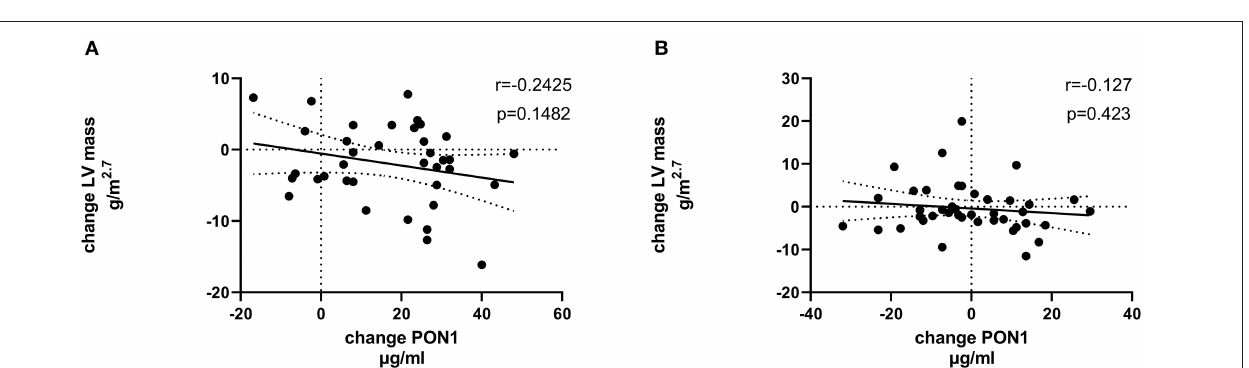
exact test p = 0.74). Further, PON1 Q192R phenotype